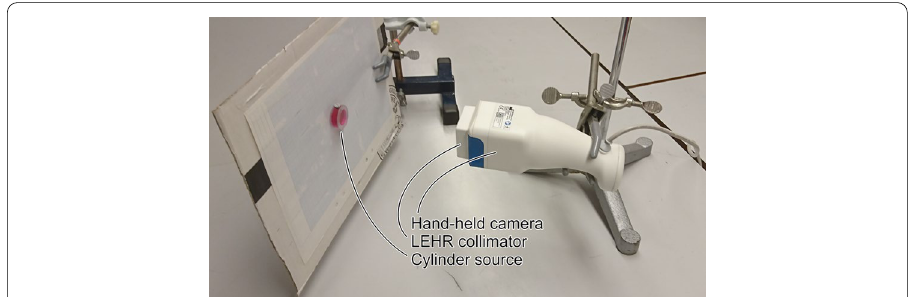
Fig. 1 Illustration of the measurement setup with the hand-held camera and the cylindrical phantom. The phantom was filled with a magenta dye to visualise the inner